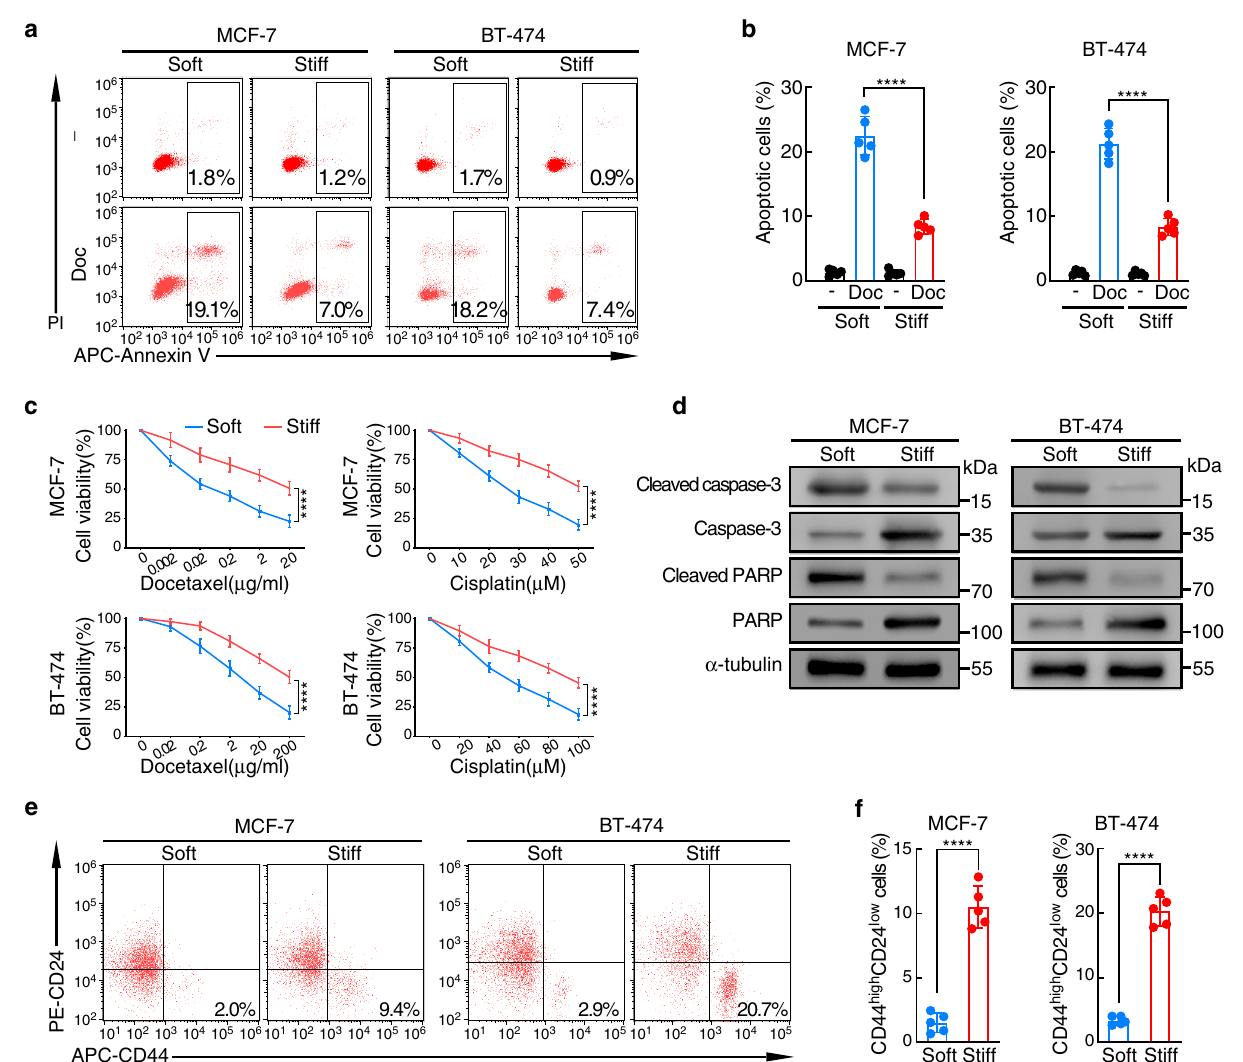
Fig. 3 | Matrix stiffness induces chemoresistance and enriches CSCs in breast cancercells. MCF-7andBT-474cellswereculturedonsoft(0.5kPa)orstiff (9kPa) supports for 2 weeks before subsequent analysis. a Docetaxel (Doc) induced apoptosisofMCF-7andBT-474wasassessedby fl owcytometry.Theproportionsof AnnexinV + cellsareshown. b Quantitationofapoptoticcells(AnnexinV + )inMCF-7 and BT-474 cells in (a) ( n =5 biologically independent experiments). Mean ± SD, **** p <0.0001 by two-sided two-way ANOVA with Tukey test. c MCF-7 and